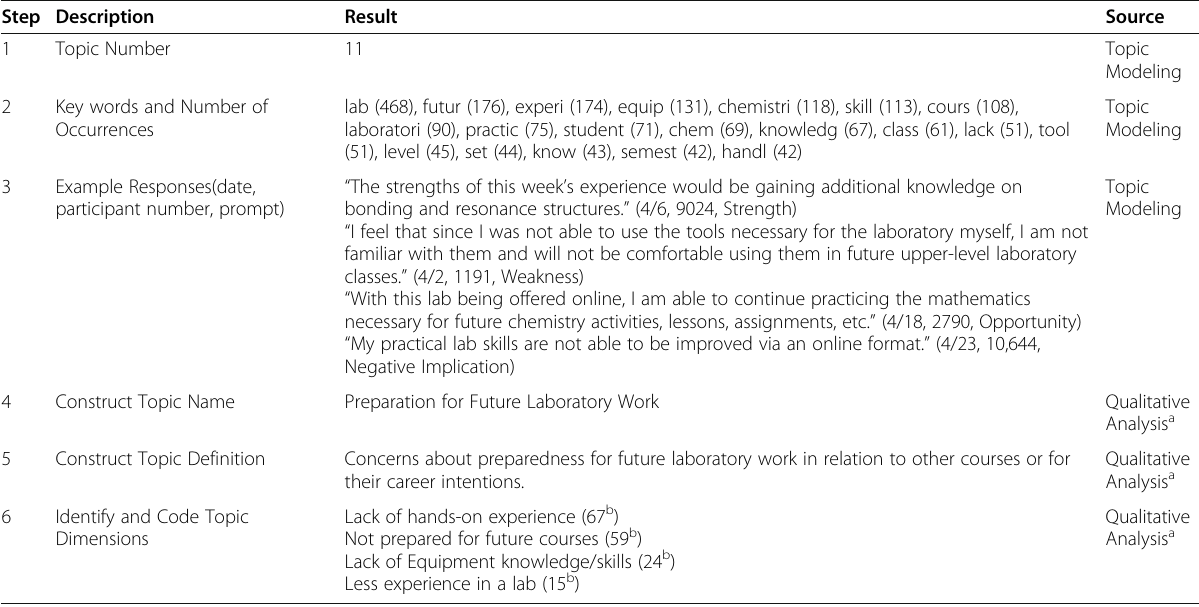
Table 3 The analytical derivation of Topic 11 as Preparation for Future Laboratory Work using sequential explanatory mixed